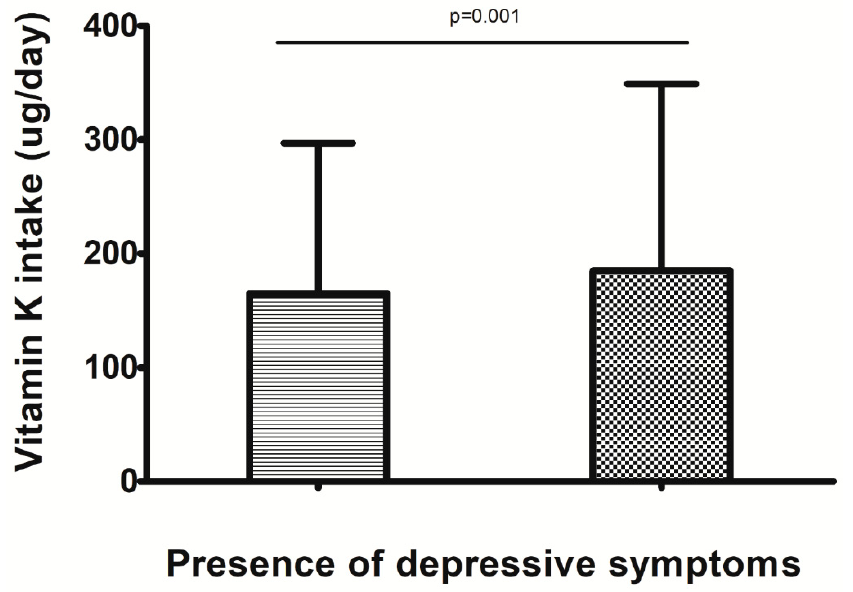
Figure 1. The data are reported as means with their standard deviations. Left column = individuals with depressive symptoms; right column = individuals without depressive symptoms.